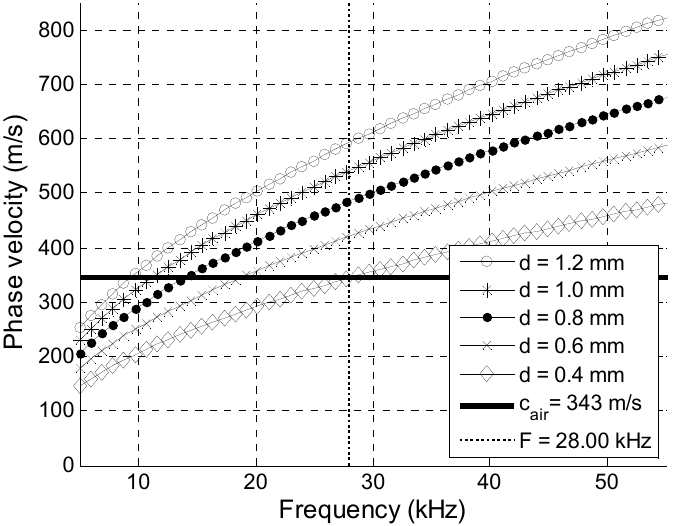
Figure 2. Phase velocities of A 0 Lamb wave mode in Gorilla ® Glass 6 plates of different thicknesses d .